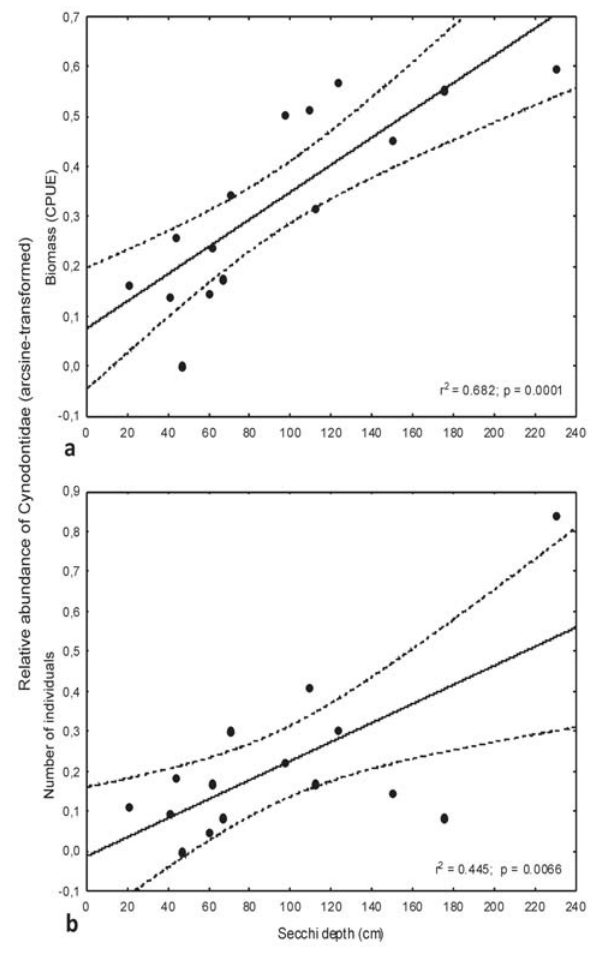
Fig. 2. Linear regression between relative abundance in biomass (a) and number of individuals (b) of Cynodontidae species and water transparency from 15 sampling sites in the Bananal floodplain, Mato Grosso,